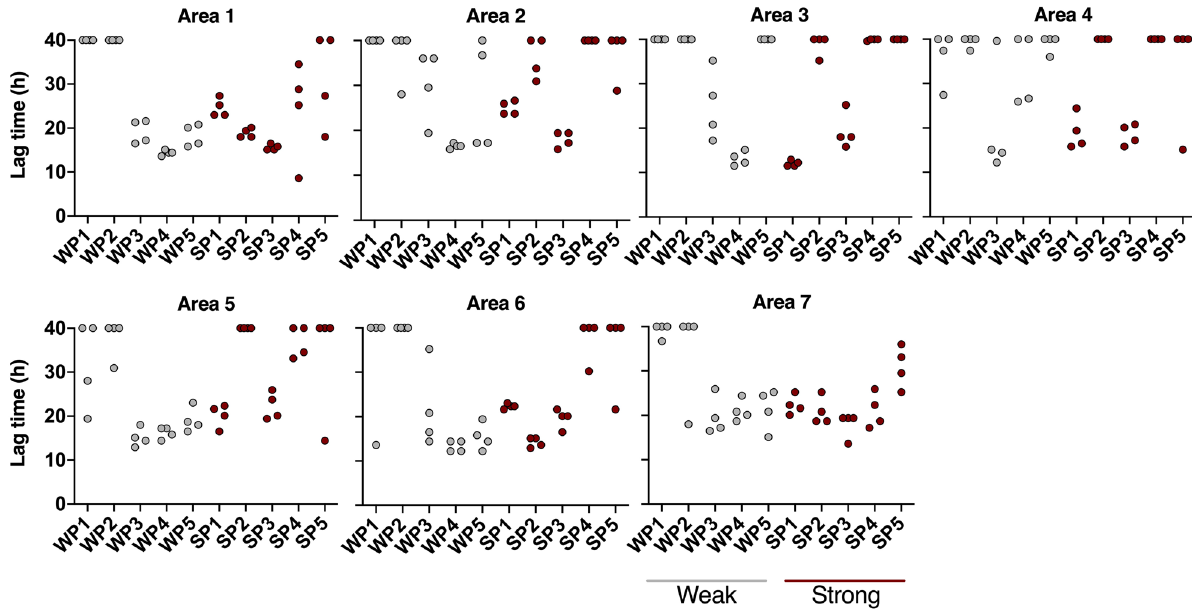
Figure 4. Lag times of RT-QuIC reactions seeded with ear pinna homogenates prepared from different areas (see Fig. 2) of five weak ELISA-positive (WP, grey) and five strong positive (SP, maroon) deer. Samples were subjected to IOME-RT-QuIC. Lag time (time to reach 10% maximum ThT fluorescence on the plate) within the cutoff time of the assay (40 h). Reactions with lag times of ≥ 40 h are aligned at the top of each status of the donors. Using the criteria described in the Materials and Methods for calling the samples positive or negative overall, 24 of the ear samples were positive (Table 2). Twenty-one of those samples were from deer with positive RLNs, giving an apparent diagnostic sensitivity of 81% based on the RLN diagnosis. The 3 remaining IOME-RT-QuIC-positive ear samples were from the group of 32 total deer with negative RLNs, giving 29 true IOME-RT-QuIC negatives out 32, or an apparent diagnostic specificity of 91%.